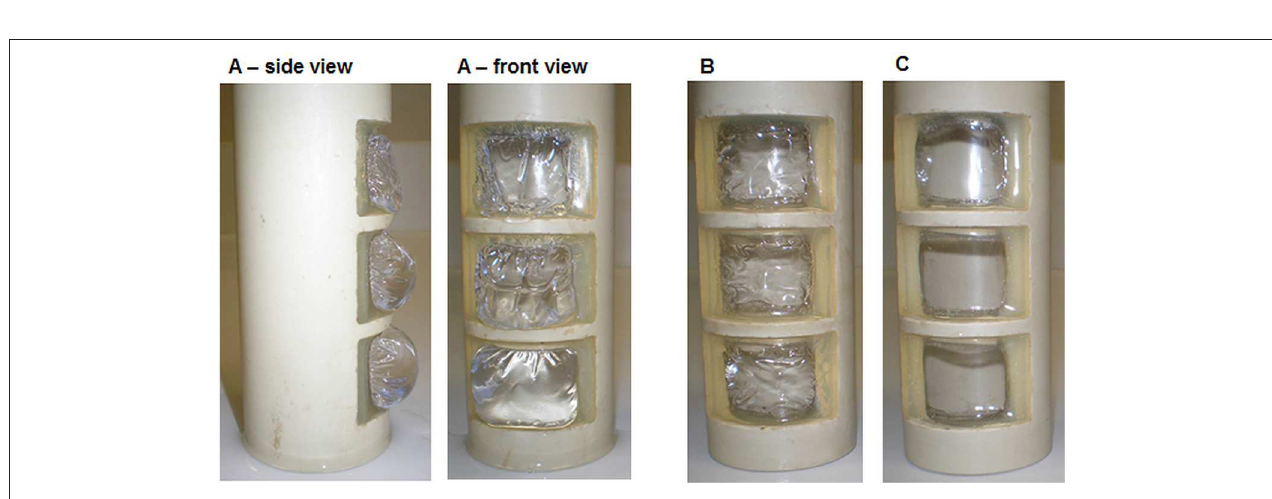
FIGURE 10 | Membrane after autoclaving in de-ionized water (A) , tap water (B) , and subsequent drying after autoclaving in tap water (C)